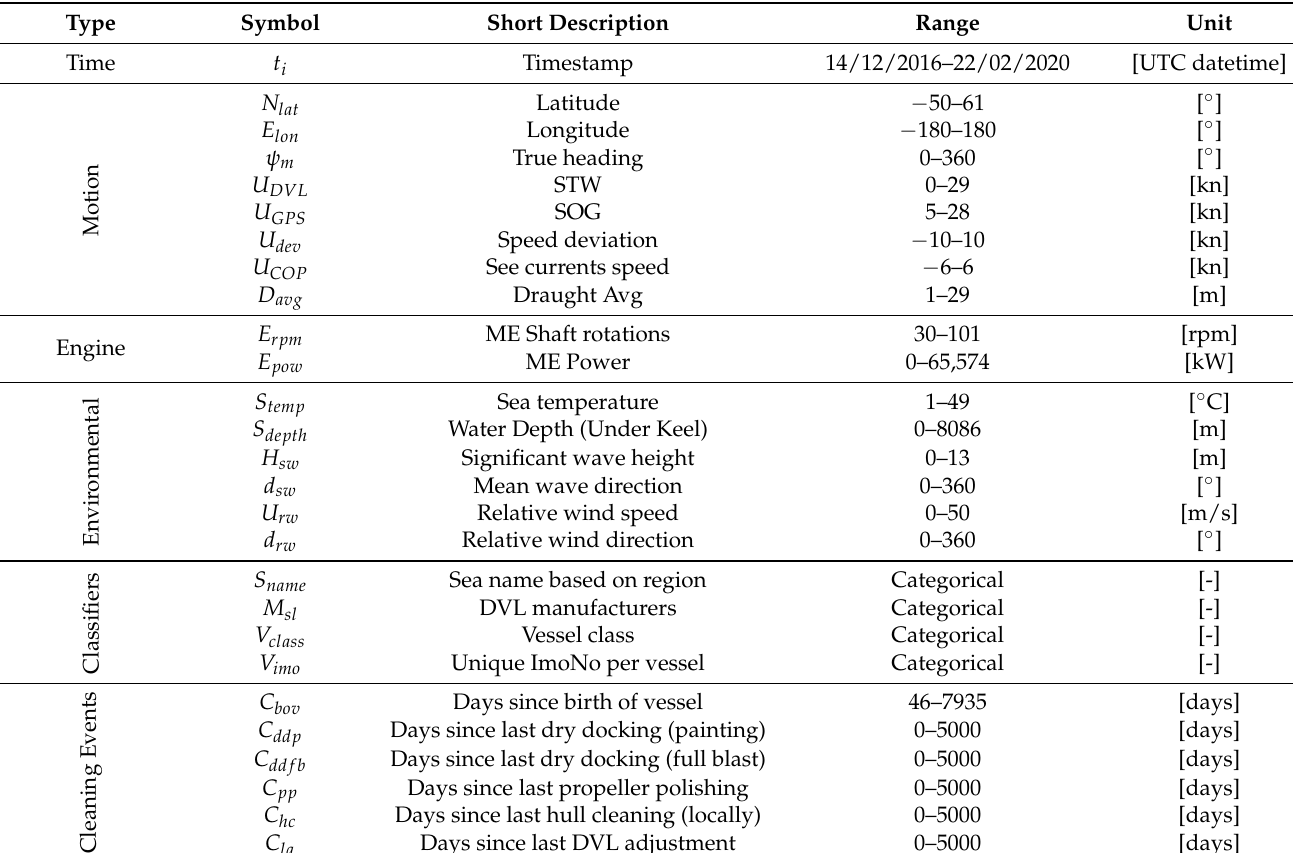
Table 8. Type, symbol, short description, value range and units for final dataset. For longer description, refer to the table at